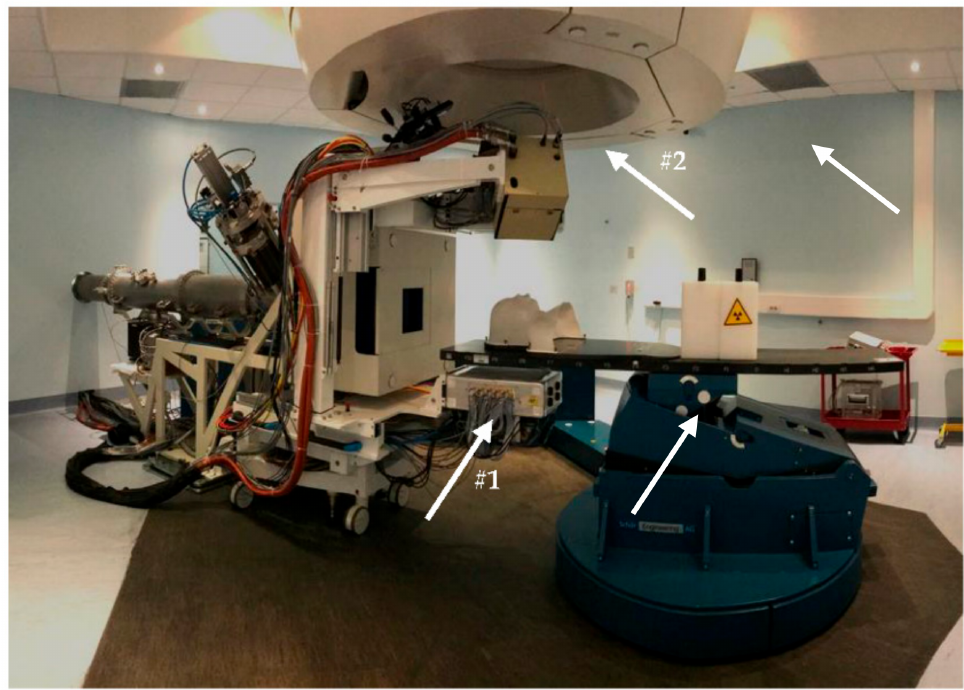
Figure 6. The INSIDE (INnovative SolutIon for DosimEtry in hadrontherapy) system in the treatment room: the lower in-beam PET (position emission therapy) detector is placed just under the couch (indicated by arrow #1) and the dose profiler is in the foreground above the patient mask (indicated by arrow